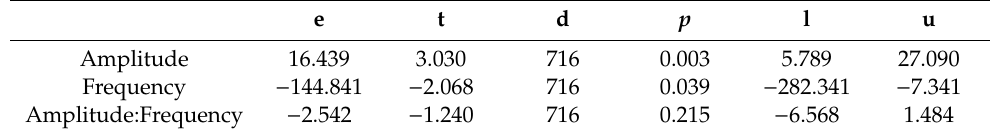
Table 3. Coefficient estimates resulting from the GLMM analysis of SSVEP amplitude for the eight recording channels. See text and Table 1 for abbreviations.